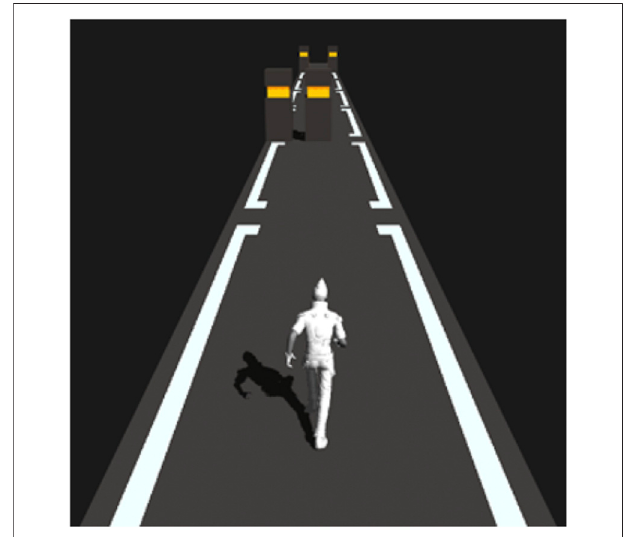
FIGURE 2 | NeuroRunner gameplay screen.